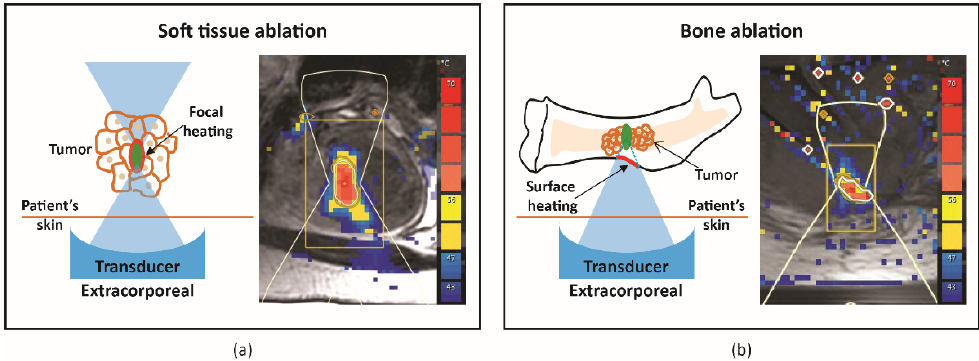
Figure 1. Schematic illustration and representative MR thermometry of uterine fibroid, soft tissue ( a ) and bone metastasis ( b ) ablation.